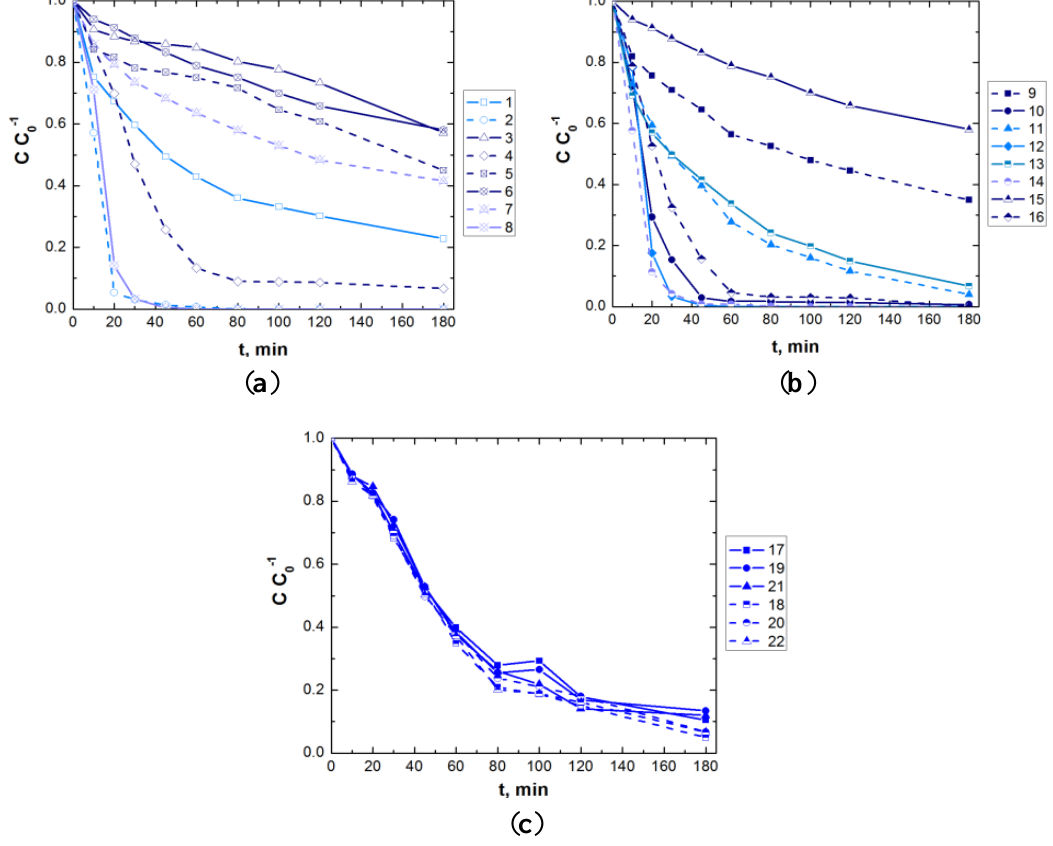
Figure 4. Evolution of color removal efficiency during EC /CAG coupling (experimental conditions are depicted in Table 3; solid line— DC , dashed line— APC ; light blue, blue and navy blue lines—low, center and high values of dye